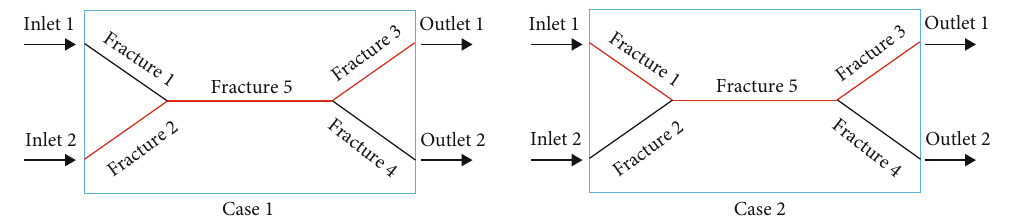
Figure 3: Schematic of the 3D fracture model (vertical view).